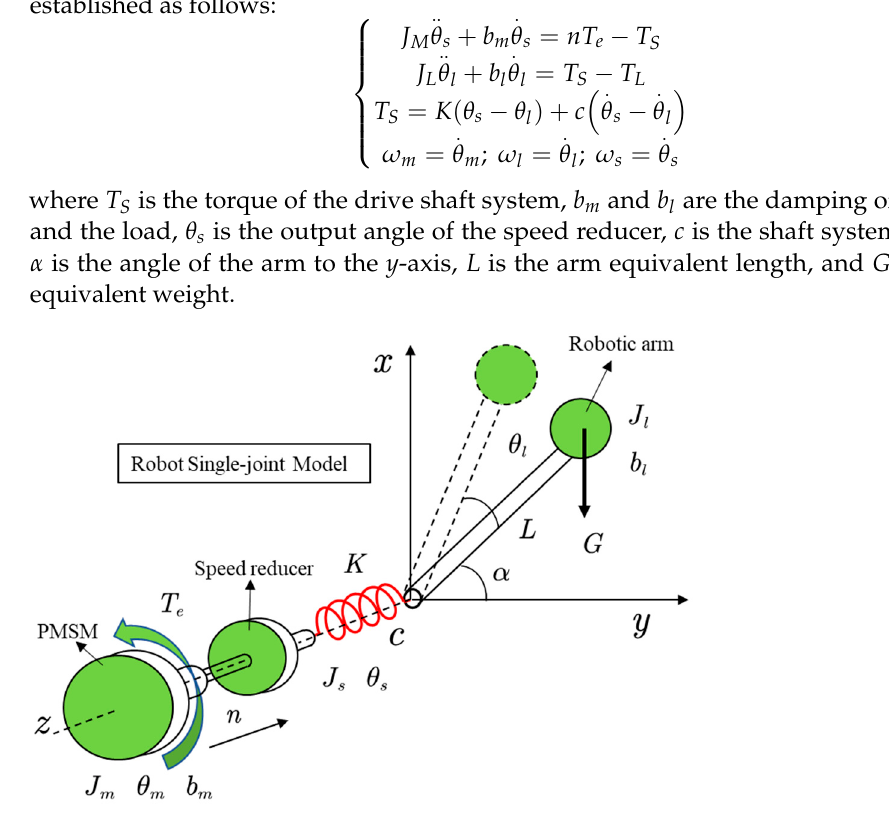
Figure 2. The double inertia model of the robot joint.